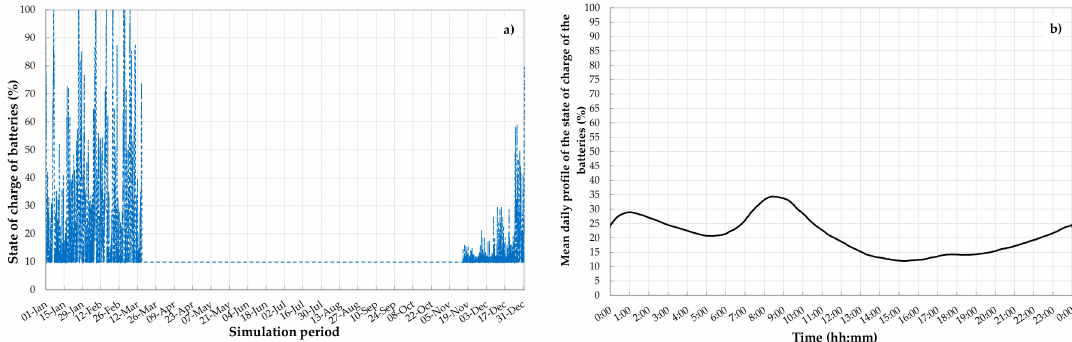
Figure 8. Values of the state of charge of the electric batteries during the fifth simulation year ( a ) and mean daily profile of the state of charge of the batteries during the heating season ( b ). Figure 9 indicates the values of PES, ∆ CO 2 and ∆ OC during the fifth operation year (PES 5th-year , ∆ CO 25th-year and ∆ OC 5th-year ) upon varying the plant configuration. This figure underlines